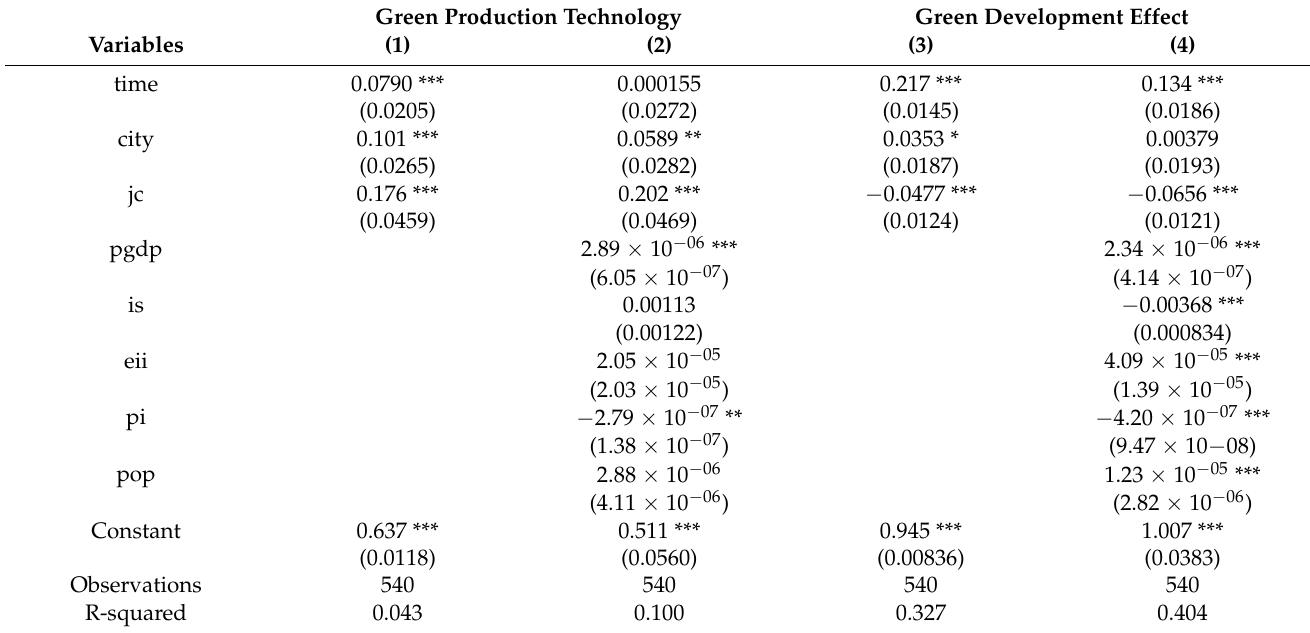
Table 7. PSM-DID